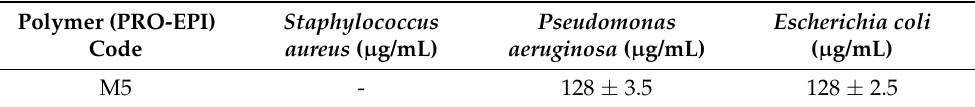
Table 1. Antimicrobial activities of polymer (M5): minimum inhibitory concentrations (MICs). Polymer (PRO-EPI)